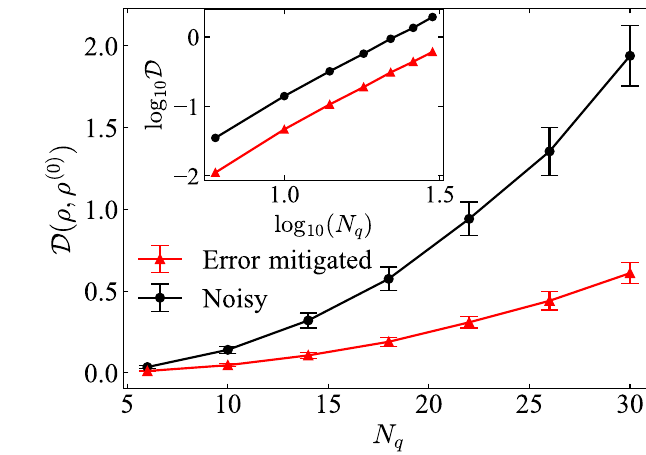
FIG. 9. Distance between ρ from noisy or error-mitigated cir- cuits without global noise and ρ ( 0 ) from ideal circuits with depth = 20. The average error rate for two-qubit gates is ε 2 = 0.01 and we take the logarithmic in the inset.